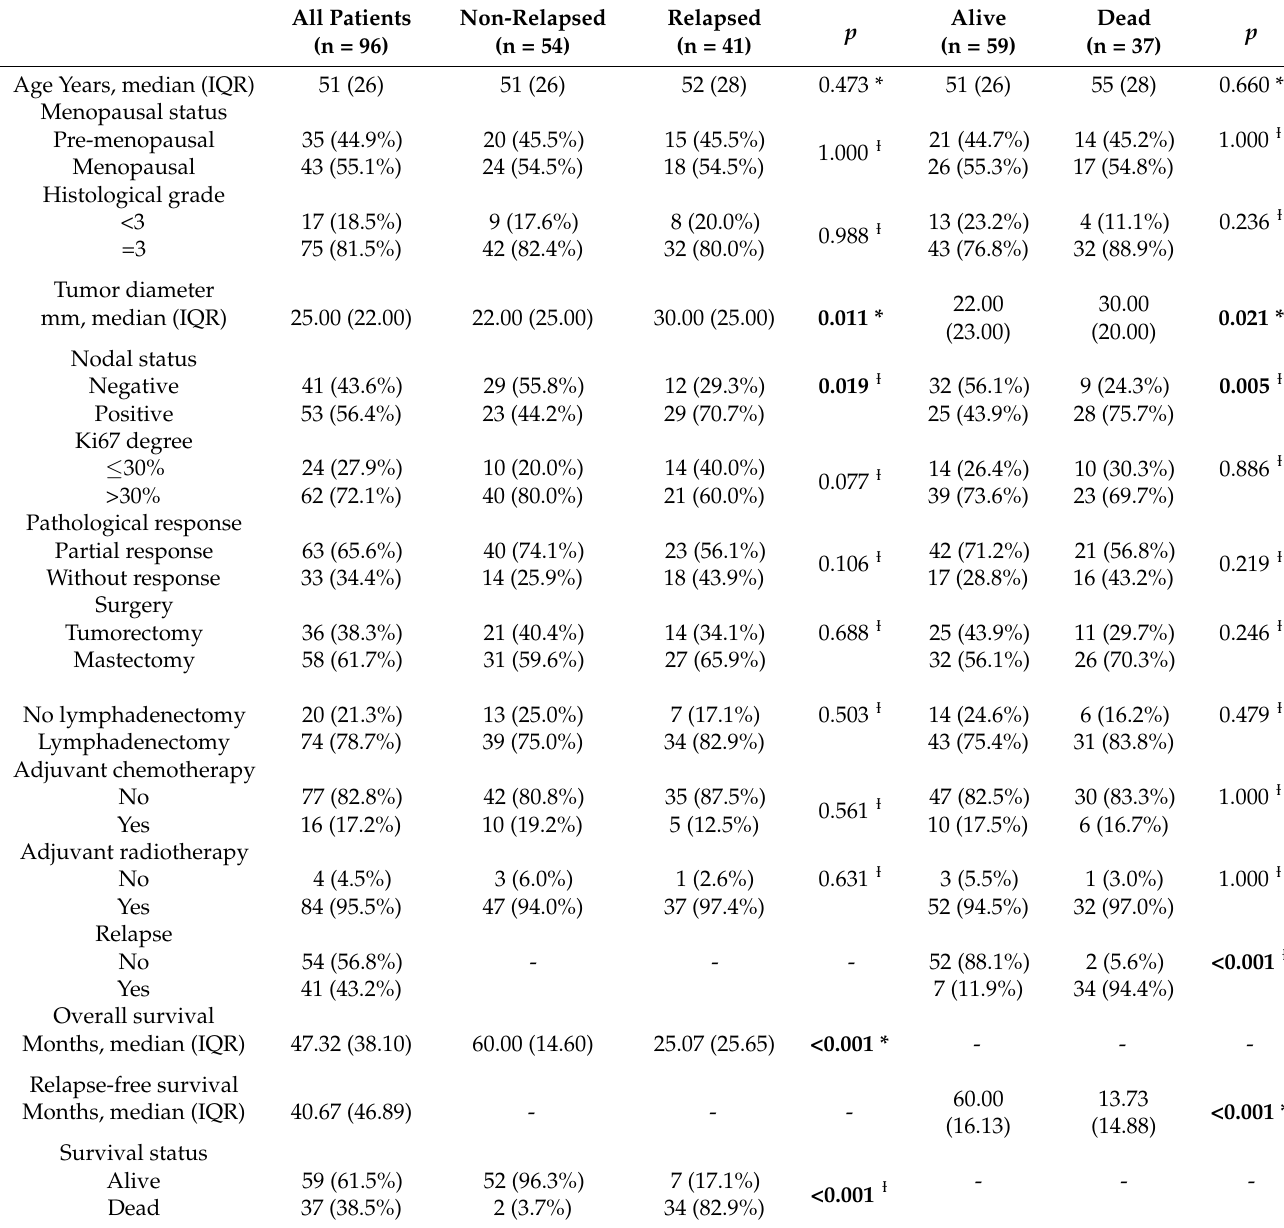
Table 1. Triple ‐ negative breast cancer (TNBC) patient characteristics, globally and by survival and relapse categories during the five ‐ year follow ‐ up.